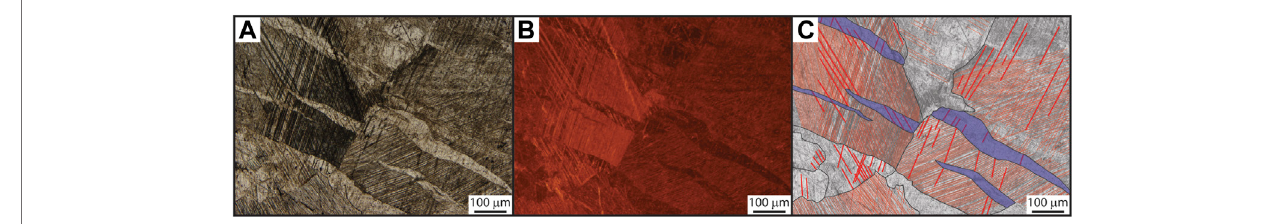
FIGURE3| Photomicrographofdeformationveincalcitewithtwinning. (A) plainpolarizedlight(PPL), (B) cathodoluminescence, (C) annotatedPPLimage.PanelC annotationsincludeTypeIandTypeIItwinsinred,andTypeIIIinblue,approximategrainboundariesaredelineatedinblack.FollowingtheconventionofBurkhard(1993) Type I and II twins are relatively thin, straight lines seen in yellow, Type III twins are thick, curved, and tapered. Type I and II twins are cross cut by Type III twins, which rarely also contain straight parallel and relatively thick ( > 5 μ m) tabular likely Type II